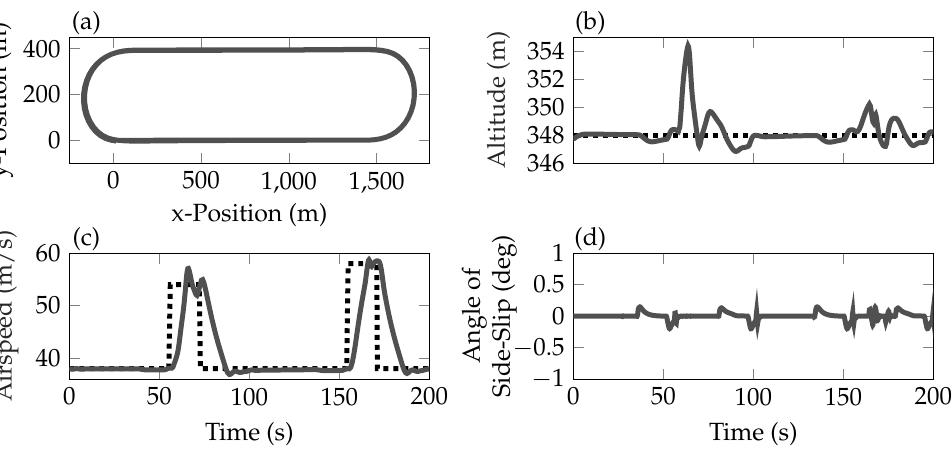
Figure 11. Simulated aircraft position during three laps on the test track in ( a ), reference and aircraft altitude in ( b ), reference and aircraft velocity in ( c ), and angle of attack in ( d